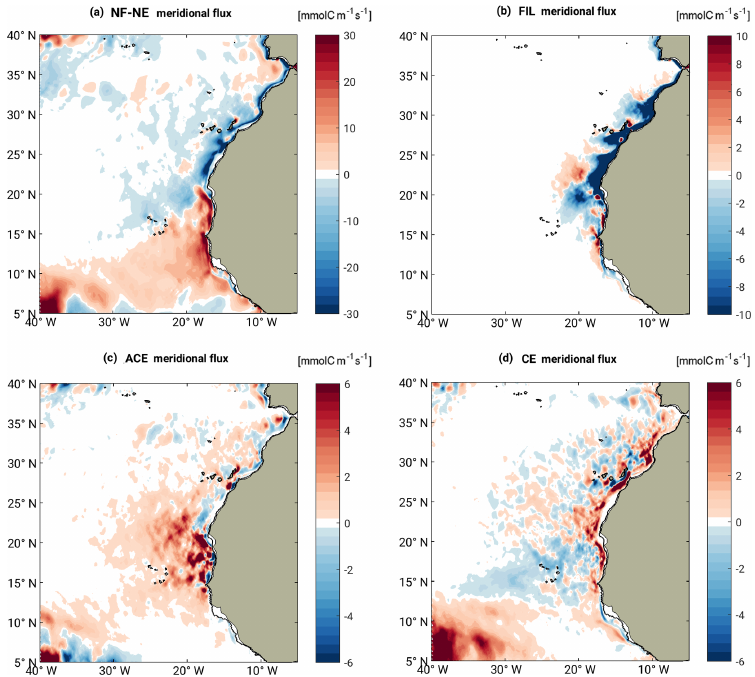
Figure B10. Decomposition of the meridional advective transport of C org into: (a) non-filament-non-eddy (NF-NE) flux, (b) filament (FIL) flux, (c) anticyclonic (ACE) flux and (d) cyclonic (CE) flux. Fluxes [mmolCm − 1 s − 1 ] are integrated in the first 100m depth.